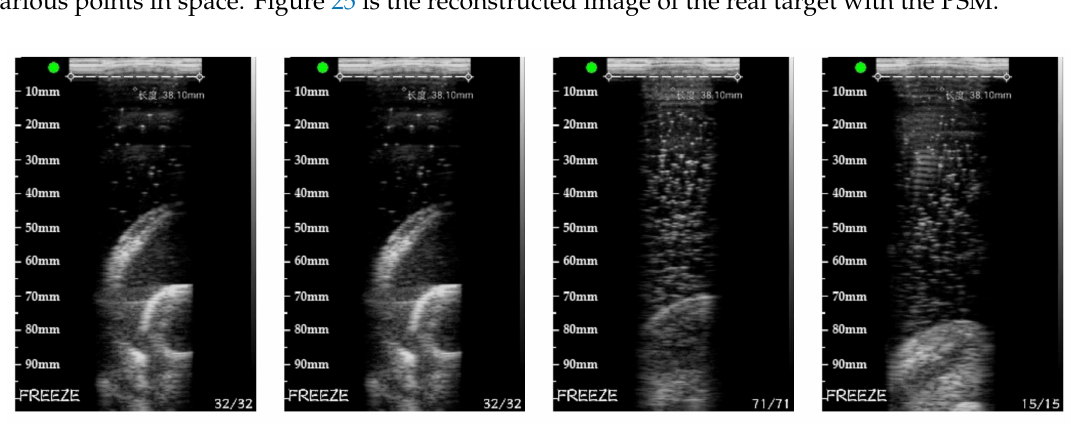
Figure 24. Cross-sectional images collected by the probe. Figure 25. Reconstructed image of the real target with the PSM: ( a ) The real target; ( b ) The reconstructed image. 6. Conclusions This paper proposes a freehand 3D ultrasound reconstruction method, PSM, based on linear ultrasound transducers. Through the three steps described above, the PSM can match the current probe sector plane to a certain plane in the Sector Database. Then, the image of the probe sector is placed in a 3D space to complete the 3D ultrasound reconstruction. The PSM is validated in two experiments: one with a numerical model and the other with a real physical model. In the case of the surface extrusion and medium change, the experimental results show that the PSM e ff ectively reduces the distortion caused by the shifted surface after pressing or the inhomogeneity of the transmission medium. There are limitations of the study. The reconstruction results are still di ff erent from the ideal situation. This is mainly due to the errors in the spatial positioning of the probe and the non-linearity